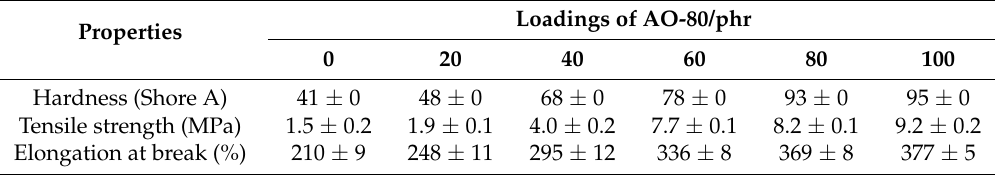
Table 1. Mechanical properties of AO-80/ACM rubber